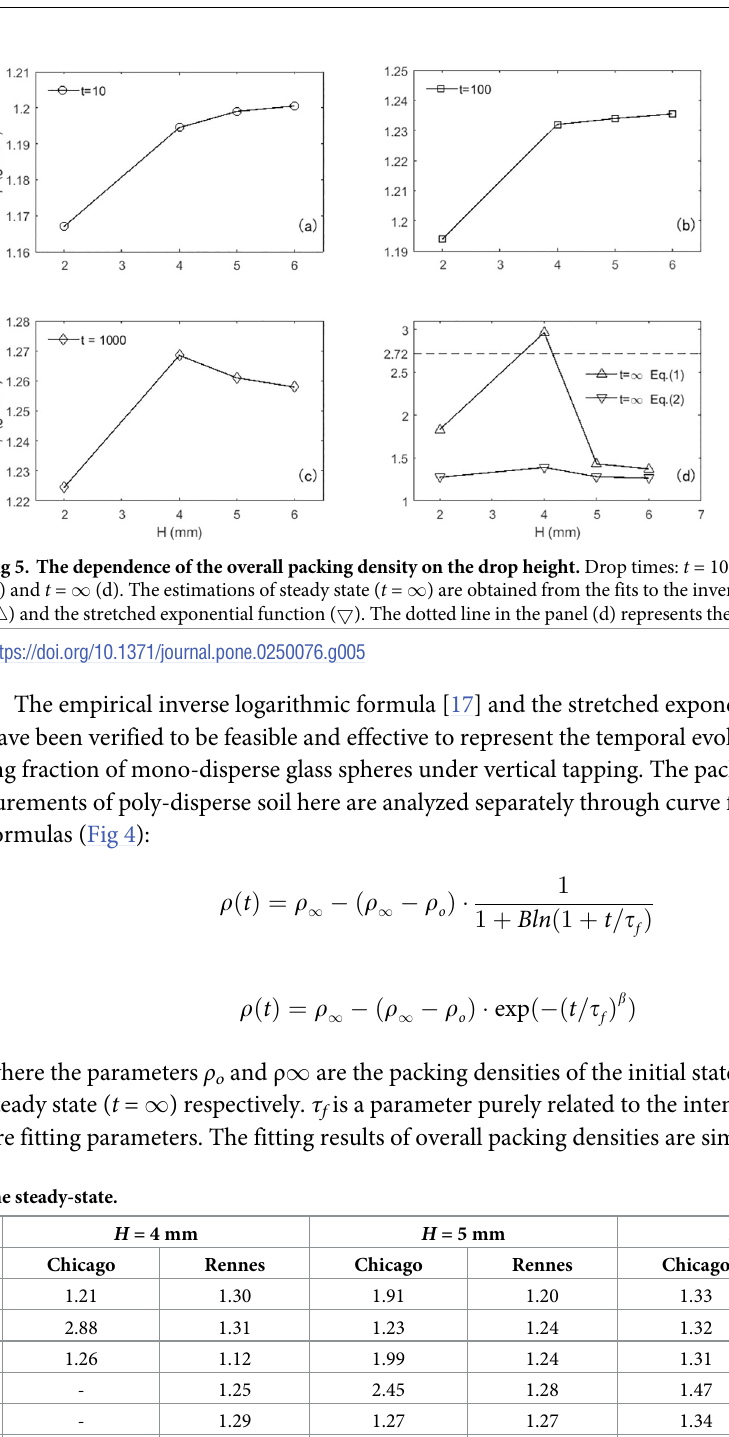
Chicago and Rennes are corresponding to Eq (1) and Eq (2), respectively. The index of each tube is numbered from the bottom up. The cells marked with “-” indicate tubes not filled due to the descent of soil free